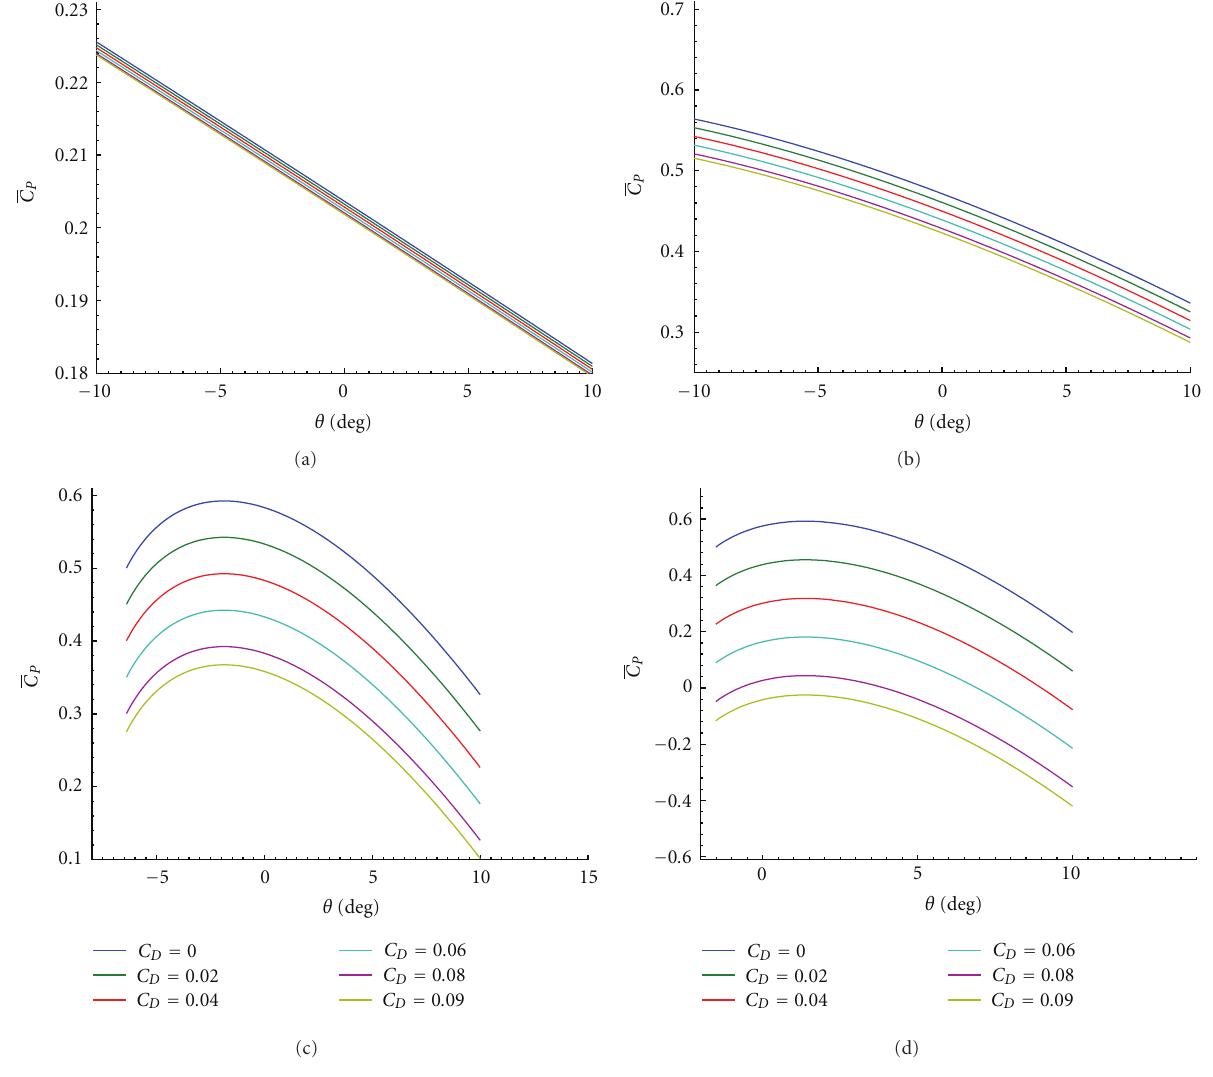
Figure 9: (a) C P versus θ for J = 1, (b) C P versus θ for J = 3(c) C P versus θ for J = 5, and (d) C P versus θ for J =